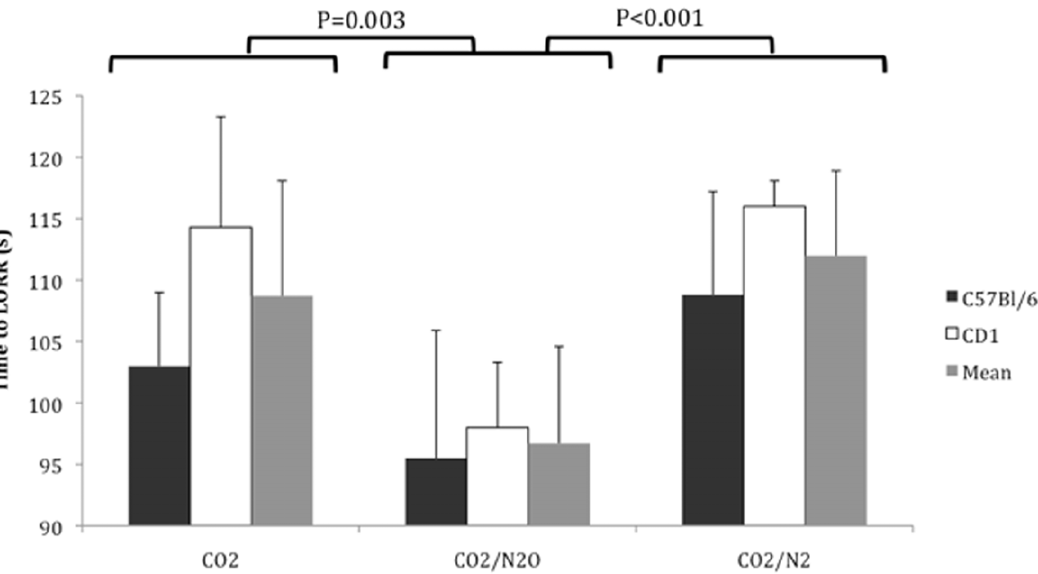
Figure 1. Time to loss of righting reflex (LORR) in seconds within the 3 treatment groups and the 2 strains of mice (C57Bl/6 and CD1). Error bars: + 1 SD. Composition of the gas mixtures for the groups 1–3: see table 3.